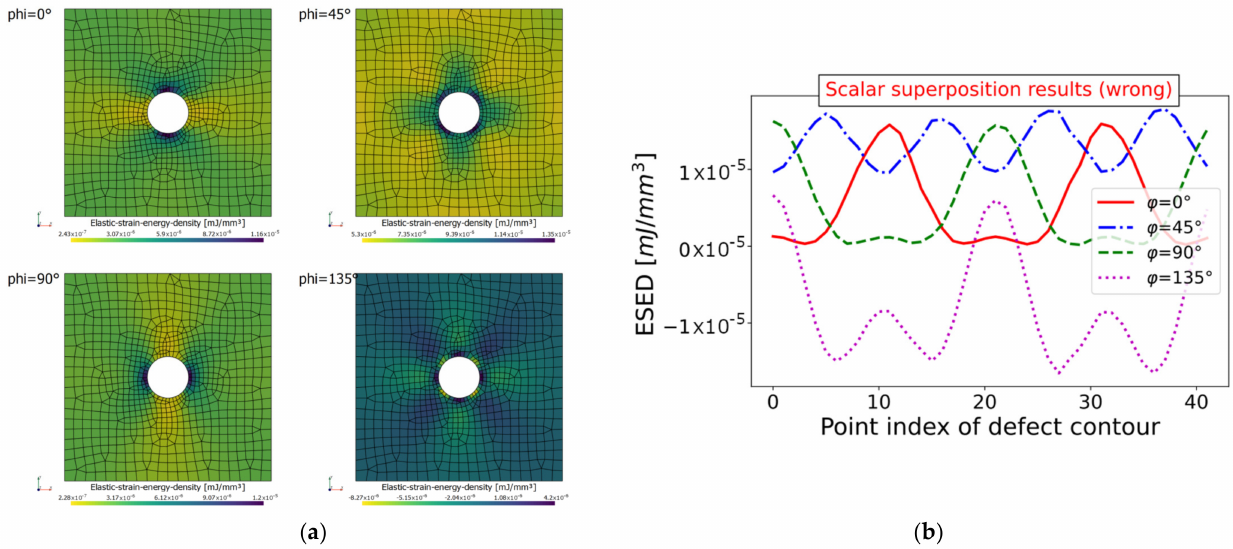
Figure 25. ESED evaluation of coarse-meshed circular hole-in-plate (mesh ‘circle_lin_R1mm_v1’) by scalar superposition: ( a ) Contour plots for load angle of ϕ = 0, 45, 90, 135 ◦ ; and ( b ) ESED plots along defect